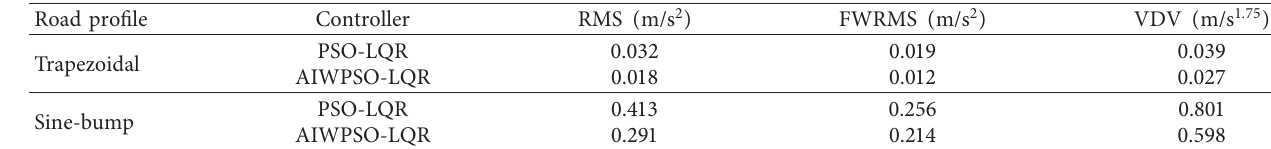
Table 5: Performance indices for